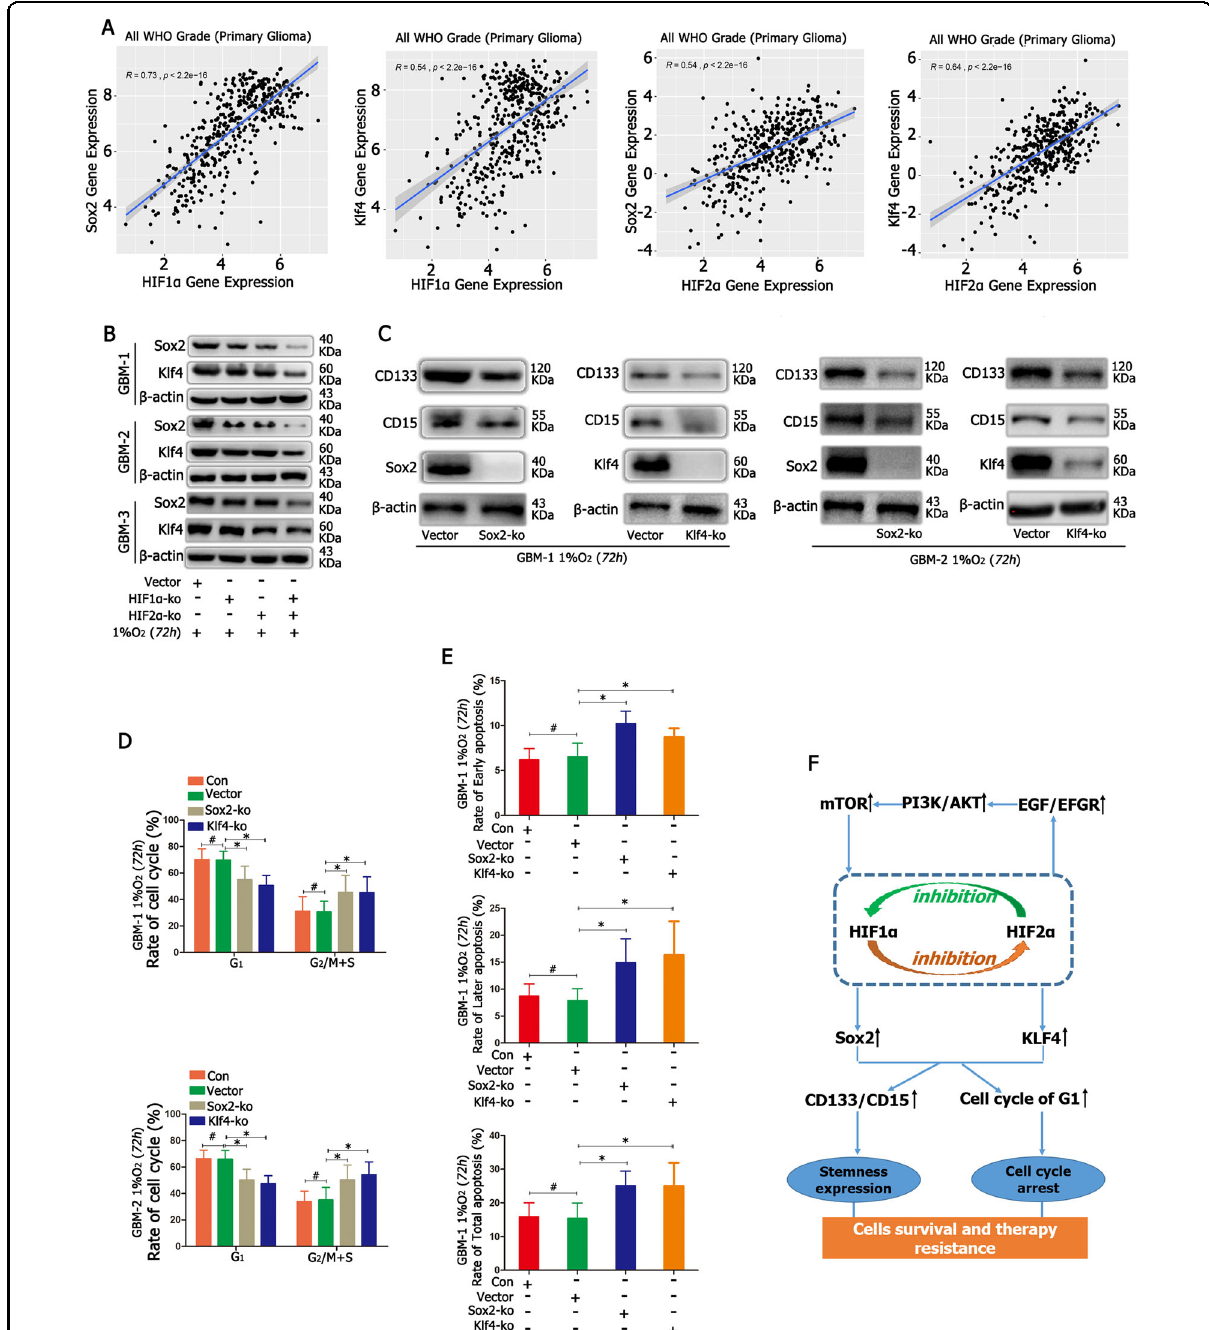
Fig. 6 HIF1 α and HIF2 α regulated GBM cell stemness expression through Sox2 and Klf4 in hypoxia. A Both HIF1 α and HIF2 α had a positive relationship with Sox2 and Klf4. B There was a lower expression of Sox2 and Klf4 after knocking out HIF1 α or HIF2 α , and the levels were lowest after simultaneously knocking out HIF1 α and HIF2 α . C Compared with the control conditions, after knocking out Sox2 and Klf4, CD133 and CD15 expression decreased signi fi cantly. D The number of cells in the G 1 phase decreased while the number of cells in the G 2 /M + S phase increased after knocking out Sox2 or Klf4. E After knocking out Sox2 or Klf4, the early, late and total apoptosis rates increased signi fi cantly compared with those in the control and empty vector cells. F HIF1 α and HIF2 α mutually regulate each other with negative feedback. HIF1 α and HIF2 α act as upstream gene regulators of EGF, and EGF regulates GBM malignancy through the EGFR – PI3K/AKT – mTOR – HIF1 α signalling pathway. In addition, HIF1 α and HIF2 α upregulate Sox2 and Klf4 expression; high expression of Sox2 and Klf4 contributes to an increase in stemness expression and the transformation of cells in the G 2 /M + S phase to the G 1 phase, thus leading to cell survival and therapy resistance. * P < 0.05 and # P > 0.05 were determined by one- way